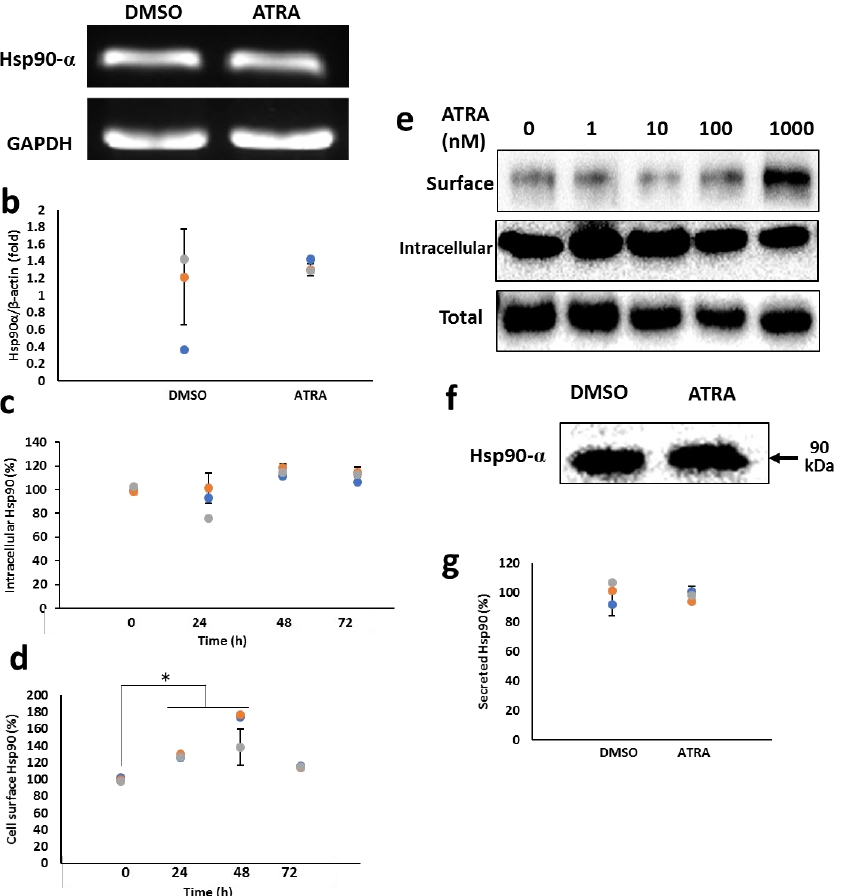
Figure 1. ATRA enhances the cell surface expression of Hsp90. ( a , b ) Hsp90 mRNA expression. THP-1 cells were treated with 1 µM ATRA for 6 h. Hsp90 mRNA level was examined by semi-qPCR ( a ) and real-time qPCR ( b ). ( c , d ) Protein expression of Hsp90. Cells were treated with 1 µM ATRA for various time points. The intracellular ( c ) or cell surface ( d ) levels of Hsp90 were measured by flow cytometry (Supplementary Figure S1). ( e ) Biotinylation and Western blotting of Hsp90. Cells were treated with various concentrations of ATRA as indicated for 24 h. Then, the cells were treated with sulfo-succinimide-biotin. Bound proteins were then eluted and immunoblotted with the anti-Hsp90 antibody. ( f , g ) Secreted Hsp90 levels. Cells were treated with 1 µM ATRA for 48 h. The levels of secreted Hsp90 were measured by Western blotting ( f ) or ELISA ( g ). * p < 0.05 vs. control group.